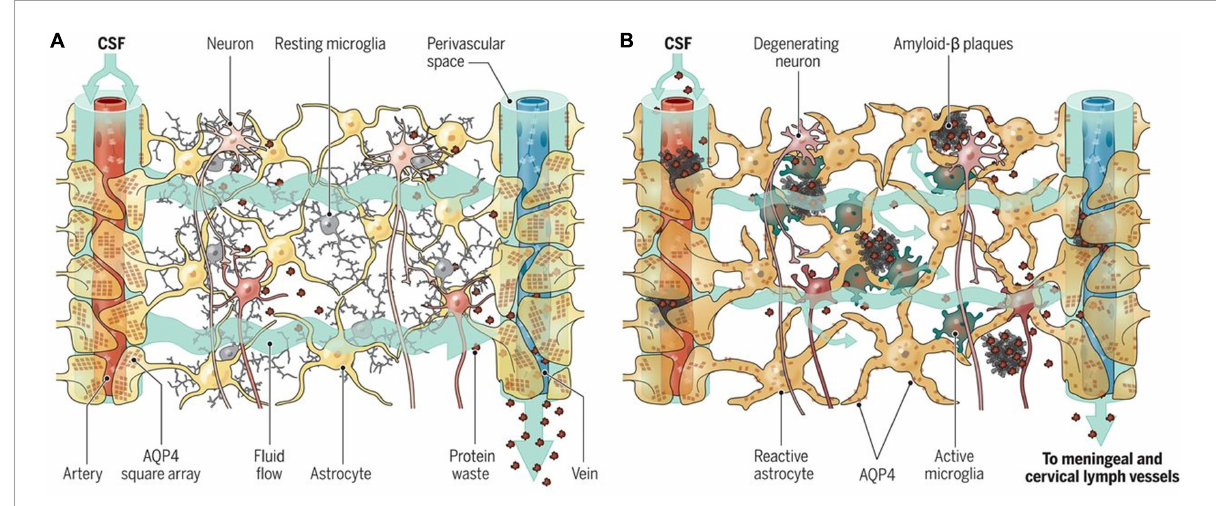
FIGURE6 Aging and the glymphatic system. (A) Adequate influx and efflux of cerebrospinal fluid (CSF) and interstitial fluid (ISF) is needed to remove unwanted metabolites from the brain. (B) With aging, glymphatic dysfunction begins to occur, which contributes to the build-up of molecules known to be associated with neurodegeneration (Da Mesquita et al., 2018). Figure reproduced with permission from Nedergaard and Goldman